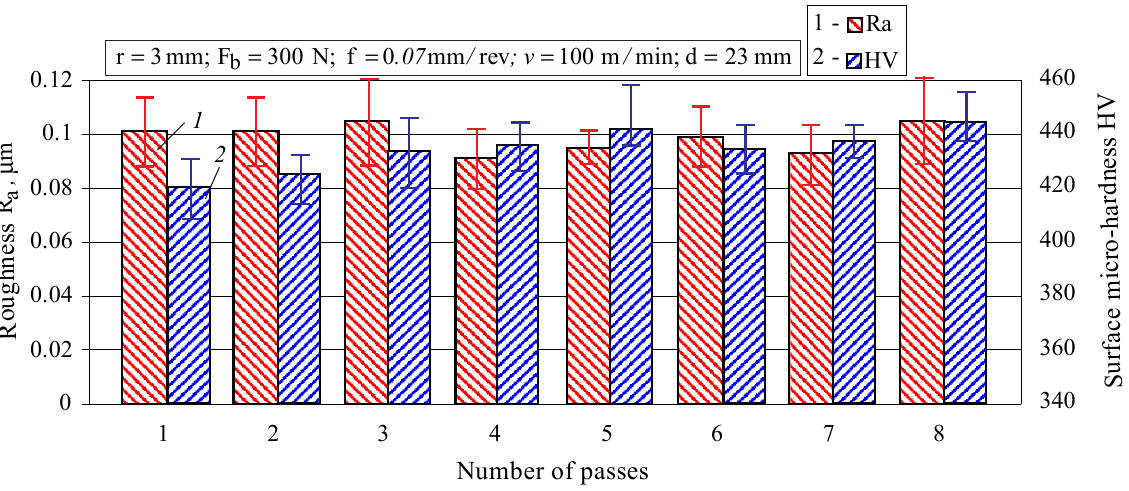
Figure 10. Effect of the number of passes on the roughness parameter R a and surface micro-hardness. The parameter R a is weakly influenced by the number of passes, and its minimum values are obtained at four passes. A steady trend is observed with an increase in the micro-hardness when the number of passes increases from one to five. A similar trend, but less pronounced, is observed with a further increase in passes to eight. DB causes cyclic loading in the vicinity of each point from the surface layer. Probably at n = 5, a stabilised cycle is reached, and the micro-hardness changes slightly for a further increase in the number of passes. Detailed information on achieving a stabilised cycle in the DB process is given in